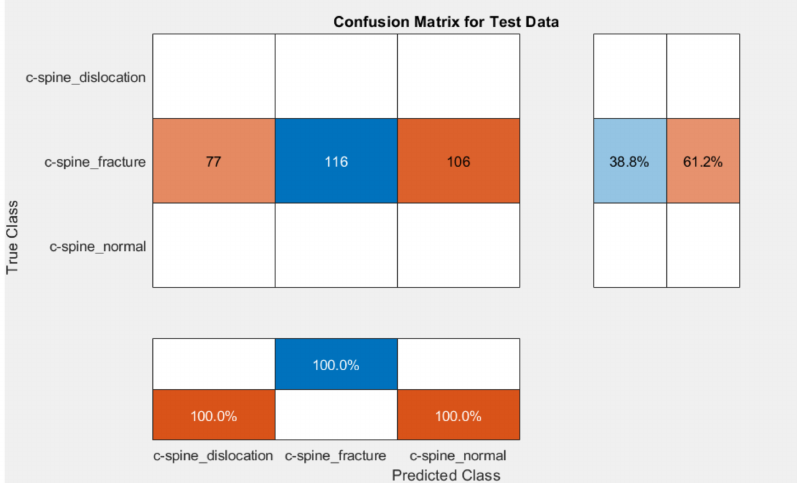
Figure 9. Confusion matrix for the proposed method using AlexNet.